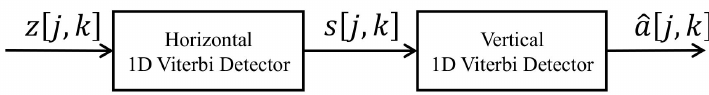
Figure 1. Structure of serial